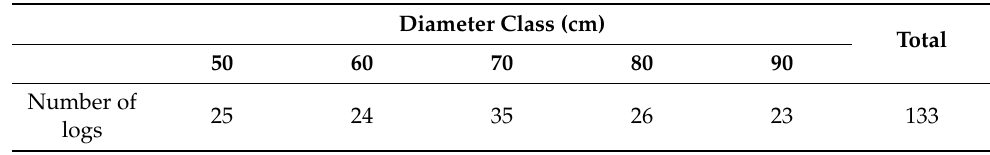
Table A2. Diameter distribution of the sampled logs used for analyzes. Diameter classes are diameters of logs rounded to the nearest tens.